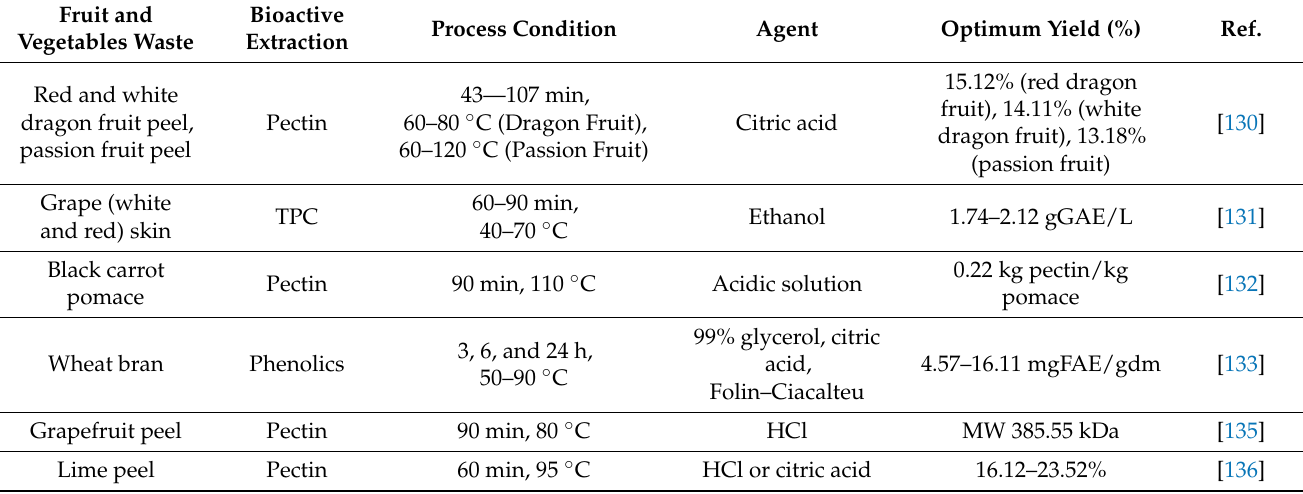
Table 4. Progress studies of FVW using conventional heating